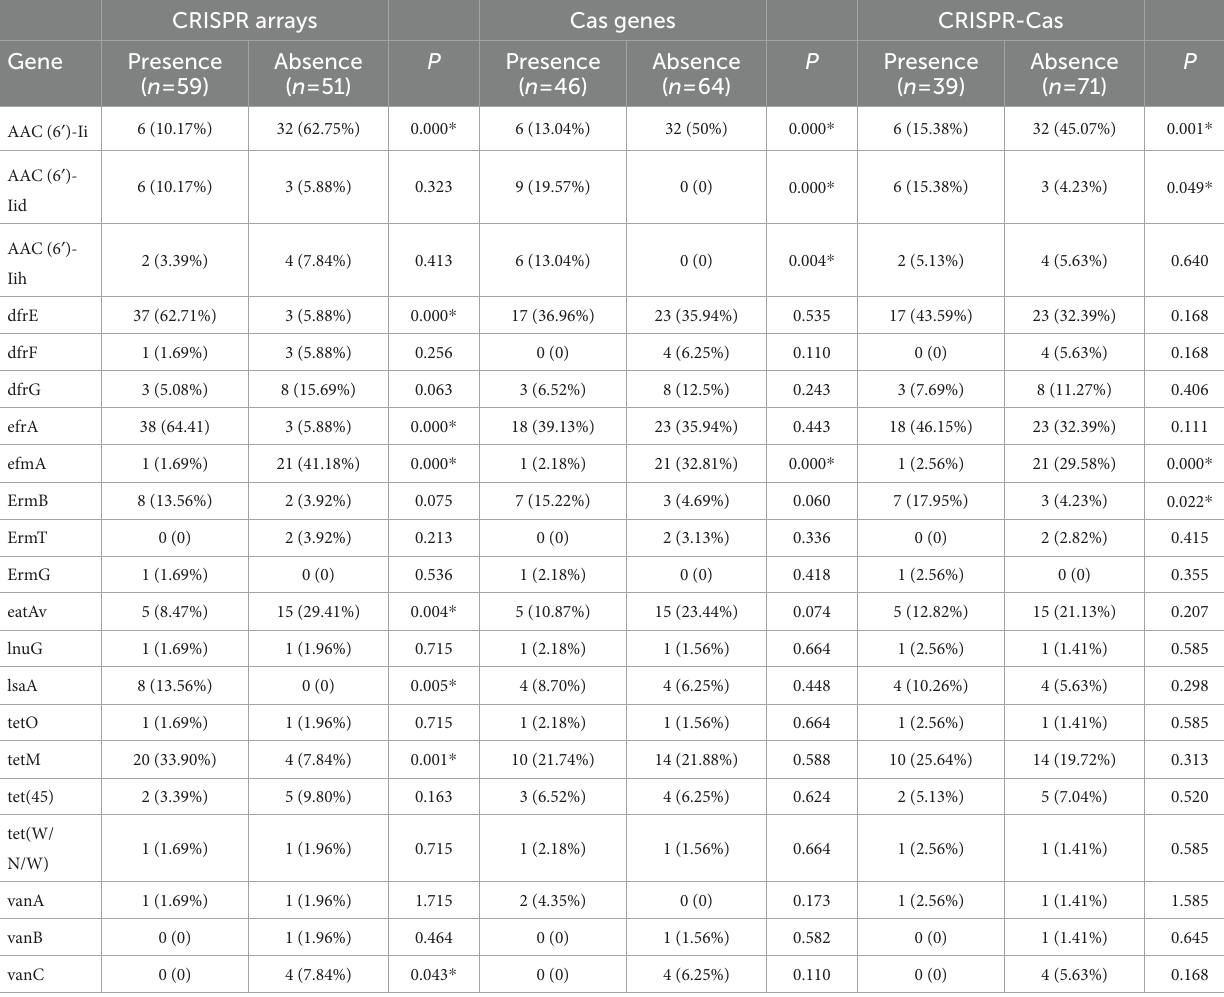
TABLE 4 The relationship between the CRISPR system and bacterial drug resistance. CRISPR arrays Cas